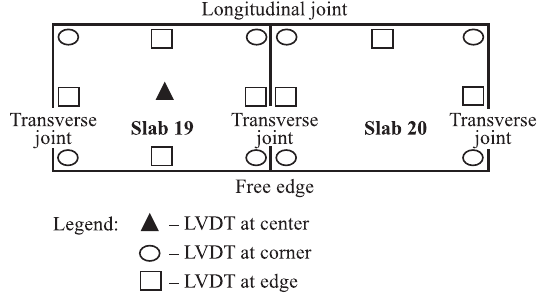
Fig. 1. LVDT instrumentation layout